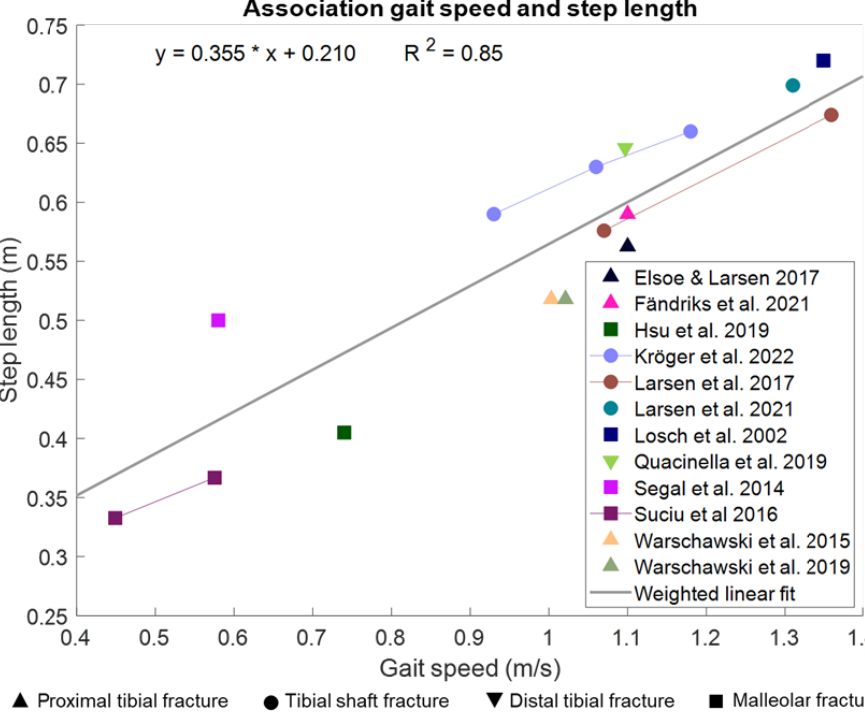
Figure 3. Linear relationship between gait speed and step length after a lower leg fracture [7,8,29,31,35,37 – 39,42,44,45,48]. Data pooled from studies with lower leg fractures, the correlation is weighted based on the number of participants per